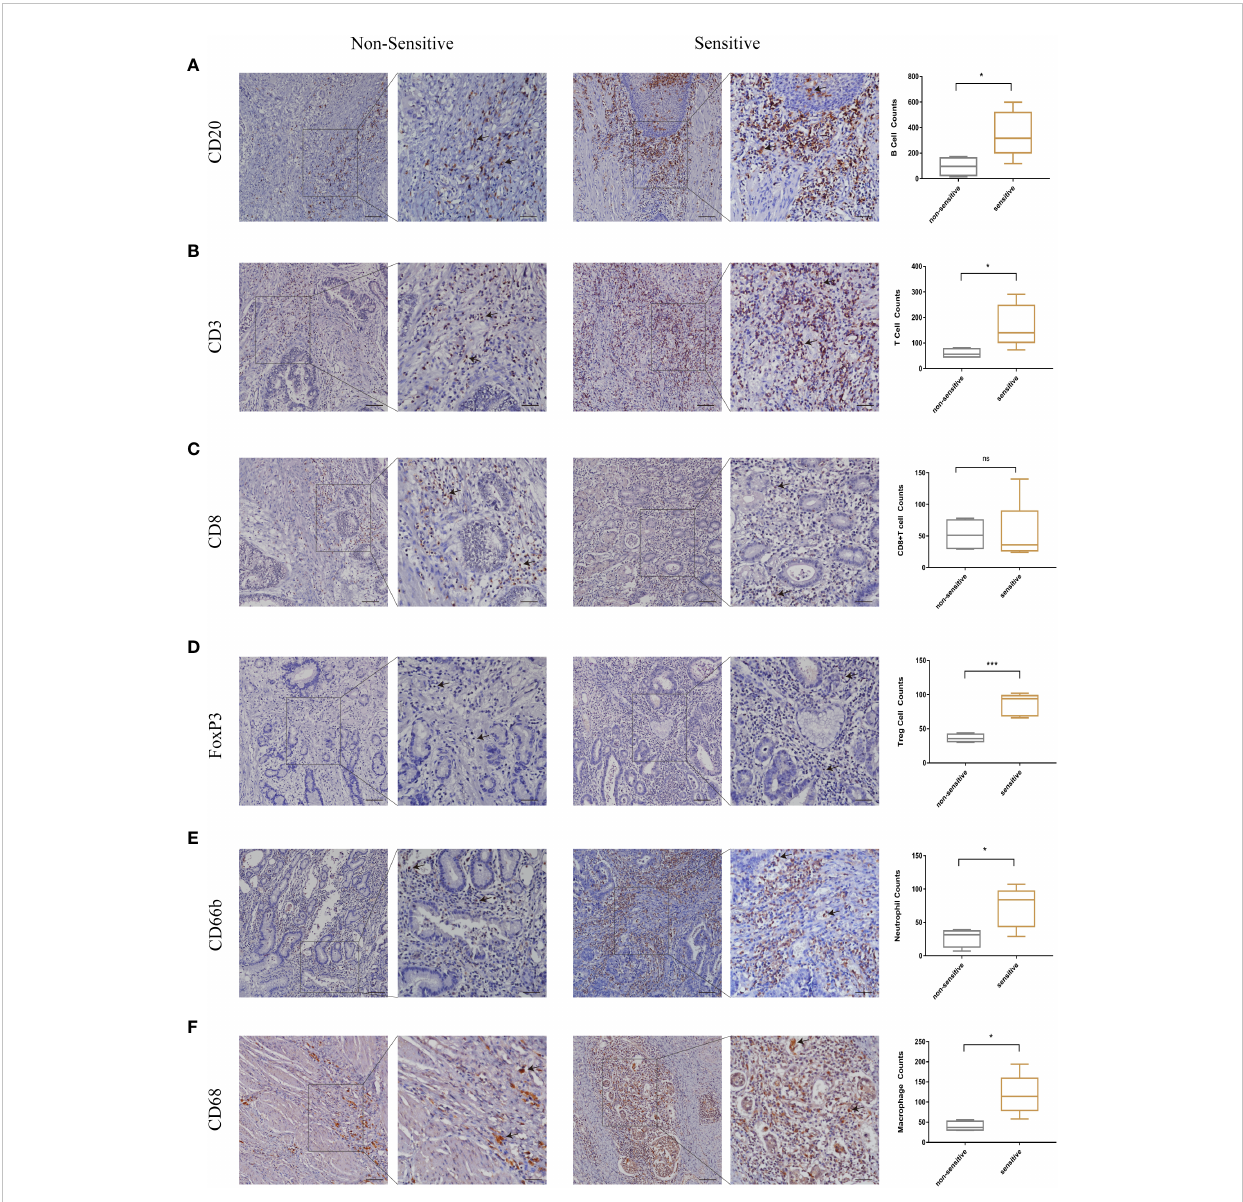
FIGURE 8 The validation of immune in fi ltration in clinical GC tissues. (A, B) the in fi ltration of B cells and T cells were higher in the sensitive group compared to non- sensitive group. (C) the expression of CD8+T cells showed no differences between the two groups. (D – F) higher expression levels of Tregs, neutrophils and macrophages were found in the sensitive group compared to nonsensitive group. Data were shown as mean ± SD. ns, p ≥ 0.05; *p < 0.05; ***p <